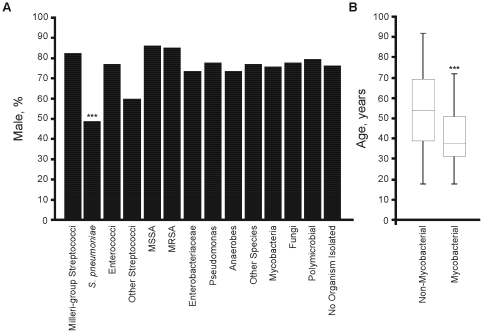
Microbiological and demographic characteristics.(A) Variation in gender across microbiological subgroups. (B) Patients with mycobacterial infections were significantly younger; data shown as median, IQR (boxes) and total range. EC, enterococci; EB, Enterobacteriaceae; Ps, Pseudomonads. ***P<0.001.